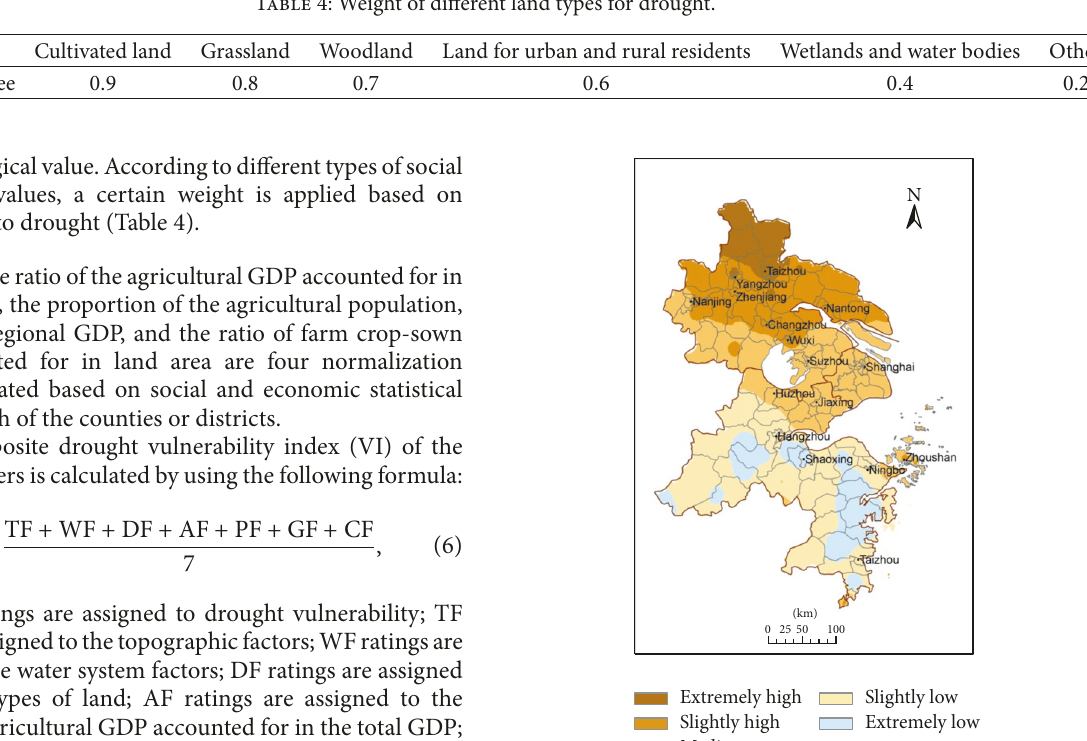
Table 4: Weight of different land types for drought.